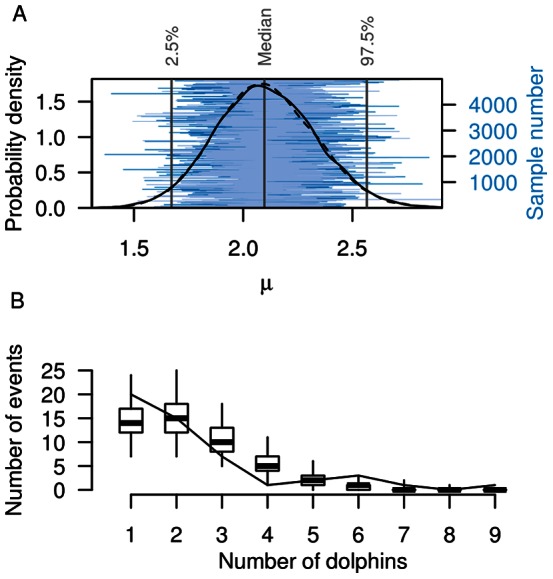
Number of common dolphin Delphinus delphis caught per capture event.
A Posterior distribution of the size of the zero-truncated Poisson distribution, , showing the probability density and trace of the two chains. B Comparison of the predicted distribution of the number of common dolphin caught per capture event between the observed captures (solid line) and samples from the model posterior (boxplots indicating the median, quartiles, and 95% confidence interval of the distributions).